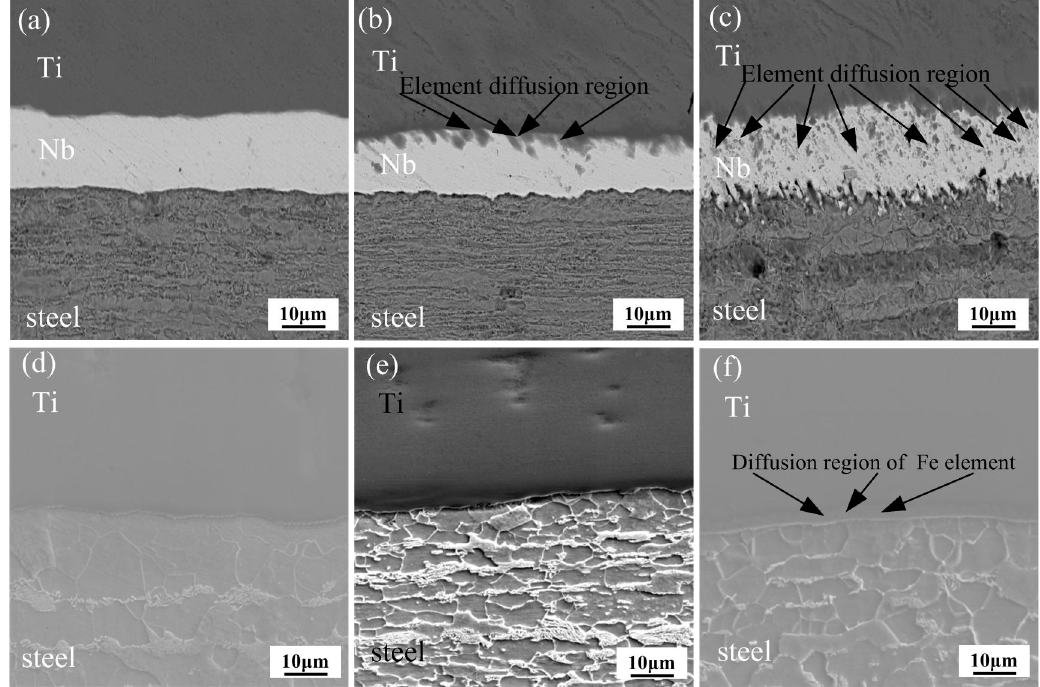
Figure 2. The backscattered electron (BSE) images of the interfaces at different heating temperatures: ( a ) 800 °C; ( b ) 900 °C and ( c ) 1000 °C for Ti/Nb/steel clad plate; ( d ) 800 °C; ( e ) 900 °C and ( f ) 1000 °C for Ti/steel clad plate.